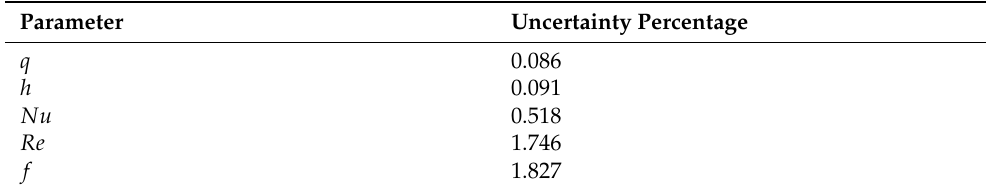
Table 4. The uncertainty of the